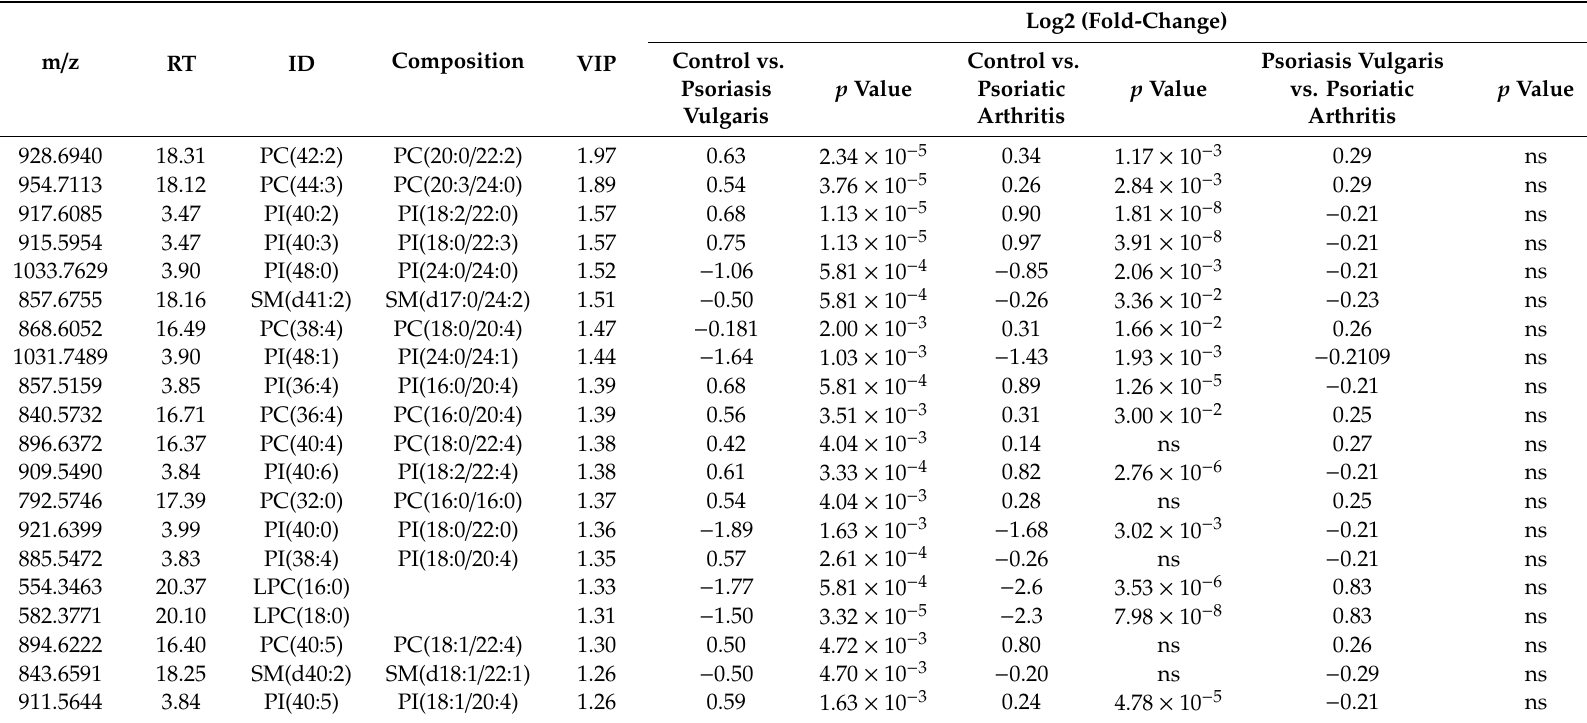
Table 1. Changes in mononuclear cells top 20 phospholipid species with VIP score greater than one comparing the healthy subjects (C; n = 10) to psoriasis vulgaris (n = 10) and psoriasis arthritis (n = 10) groups of patients; ns, not statistically